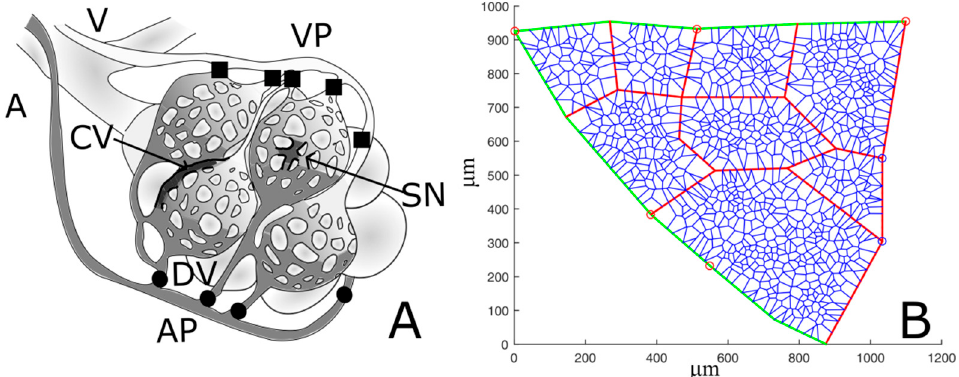
Figure 3. ( A ) simplified schema of lung alveolar capillary units. The arteriole (A) feeds the distribution vessels (DVs) and the arteriolar access points (APs) to the alveolar unit; blood flows into the two districts placed in parallel, the septal network (SN) and the corners vessels (CVs), and finally collects through the venular exit points (VPs) into the venule (V). ( B ) Representative example of an ACU network. Green and red segments represent respectively distribution vessels and corner vessels, while the remaining blue network depicts septal circulation. Red and blue circles identify respectively arteriolar access points and venular exit points.